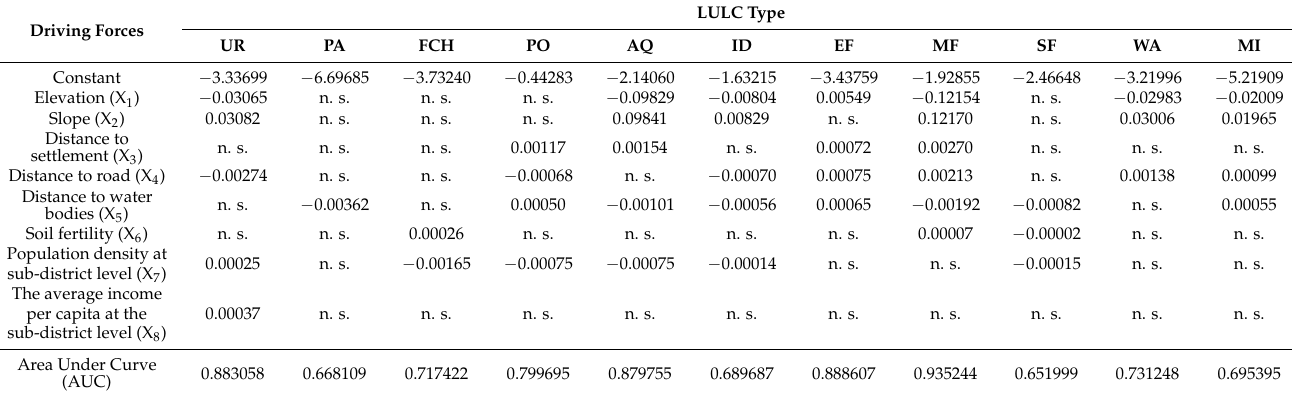
Table 10. Multiple linear regression equation of each LULC type and area under the curve value from logistic regres- sion analysis.